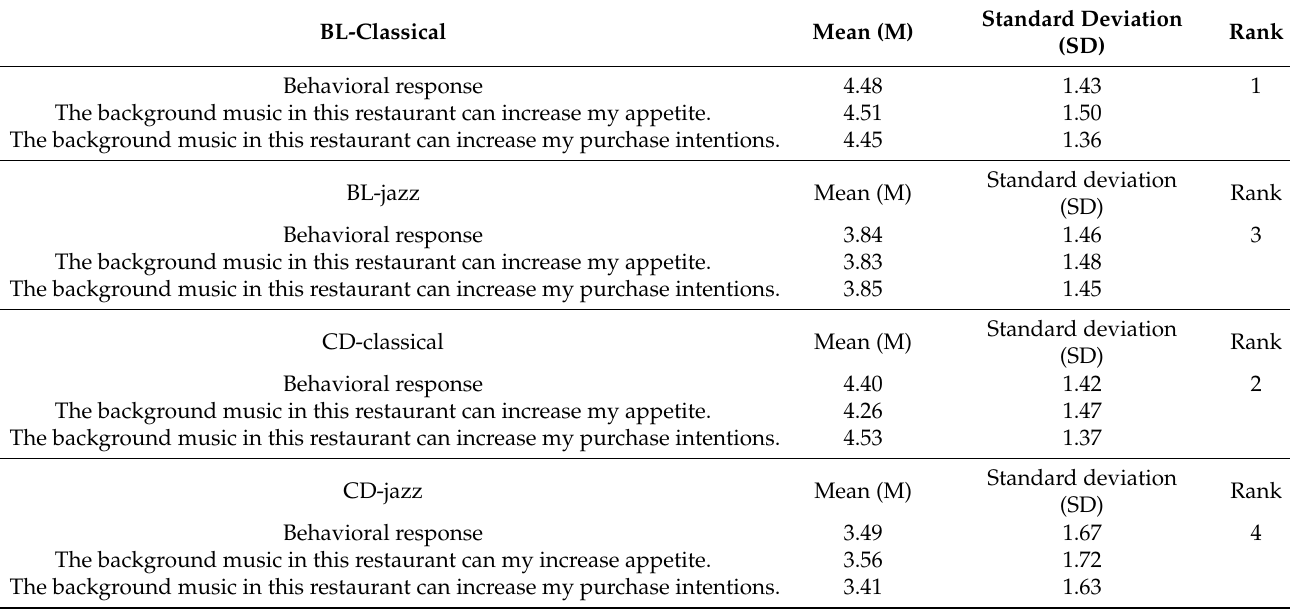
Table 5. Analysis of the consumers’ behavioral responses to the different music conditions ( n =